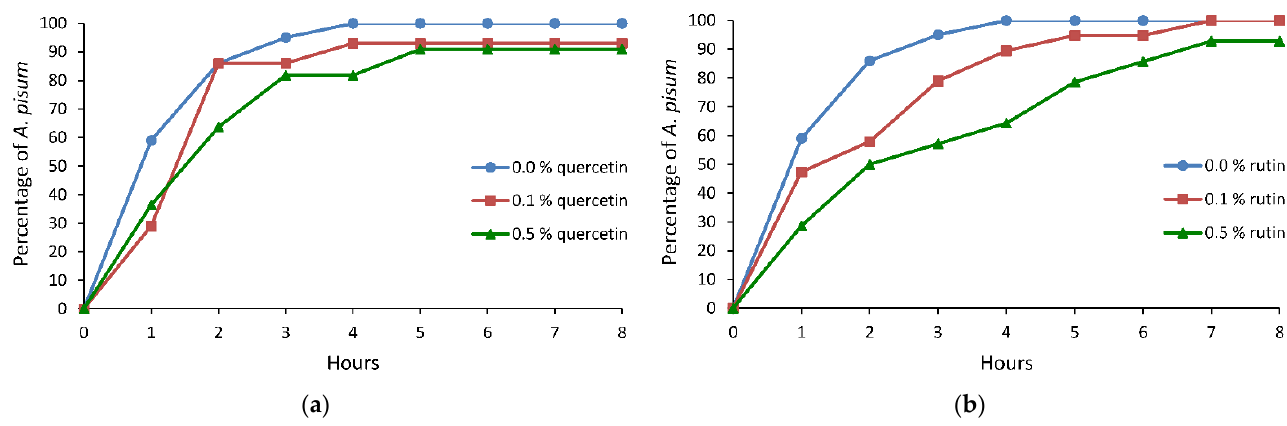
Table 2. EPG-recorded stylet penetration activities of Myzus persicae on Brassica rapa subsp. pekinensis treated with 0.1% and 0.5% ethanolic solutions of quercetin and rutin.